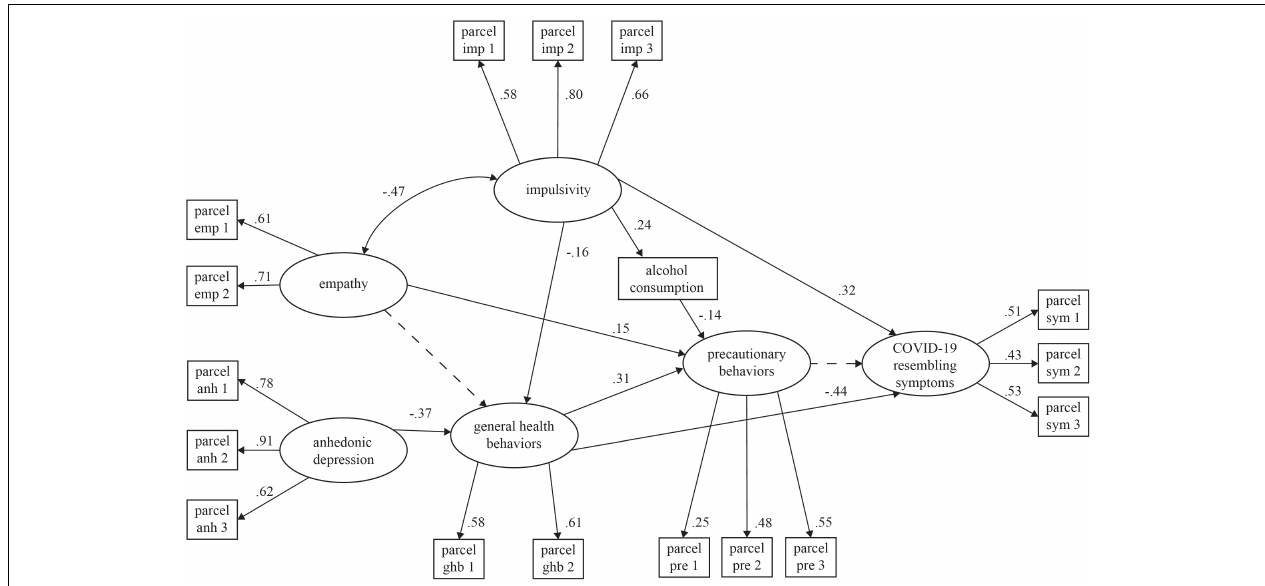
FIGURE 2 | Structural model of predictors of precautionary behaviors. All factor loadings, structural coefficients and covariances are significant ( p < 0.05), excepting the one marked with the dotted line. Goodness of fit: Satorra–Bentler χ 2 = 217.41 (108 df), p < 0.001; relative χ 2 = 2.01; BNNFI = 0.92, CFI = 0.94; RMSEA = 0.03.